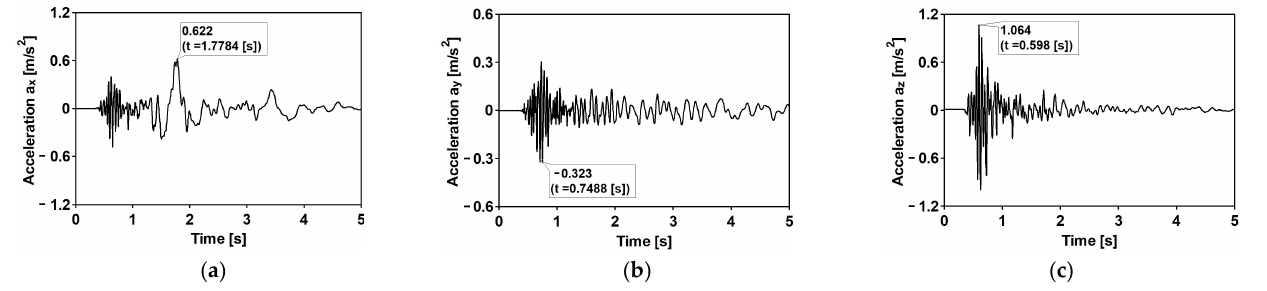
Figure 9. The time history of the registered ground acceleration for the second mining-induced shock: ( a ) horizontal direction WE; ( b ) horizontal direction NS; ( c ) vertical direction Z.